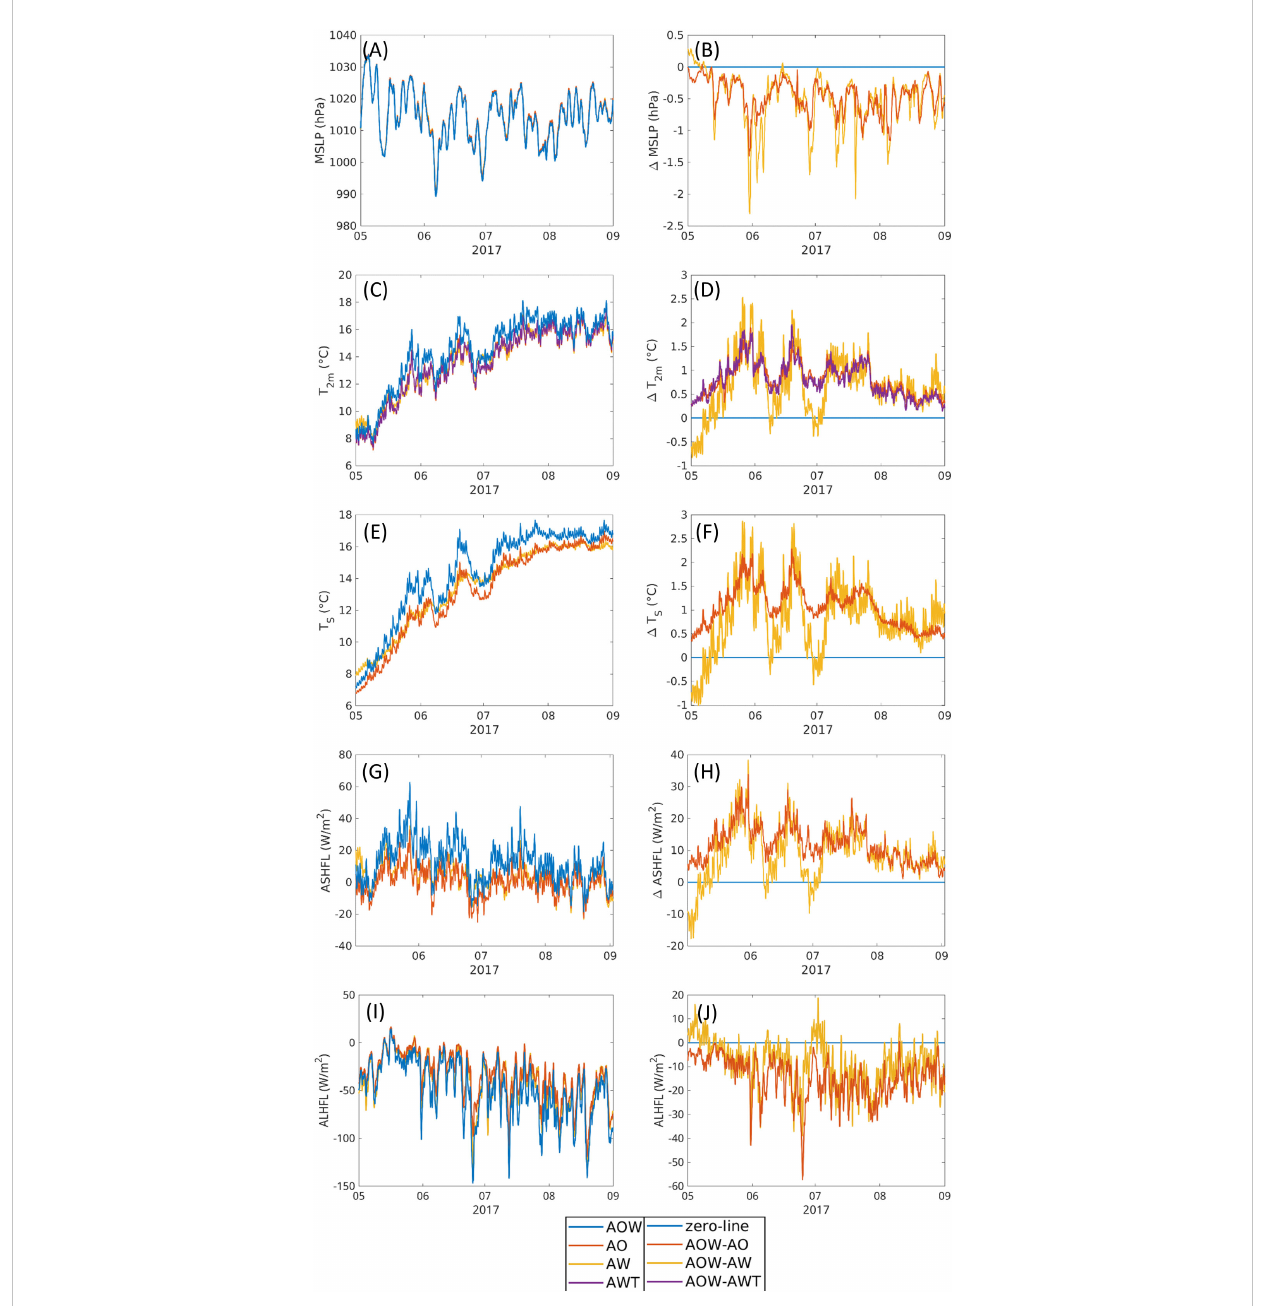
FIGURE 7 Time series of hourly values (left side) as well as differences with respect to AOW, which is represented by the zero line, (right side) of MSLP (A, B) , 2- m air temperature (C, D) , surface temperature (E, F) , sensible heat fl ux (G, H) , and latent heat fl ux (I, J) in the North Sea for summer 2017. Sensible and latent heat fl uxes are positive downward. The time series represent equally weighted